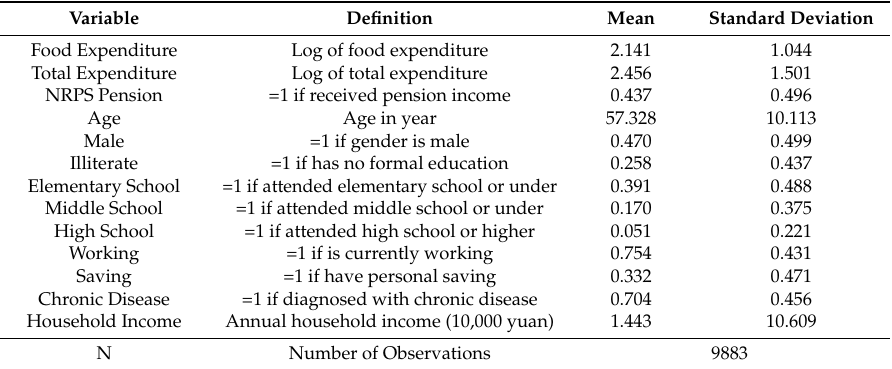
Table 1. Descriptive Statistics. NRPS—New Rural Pension